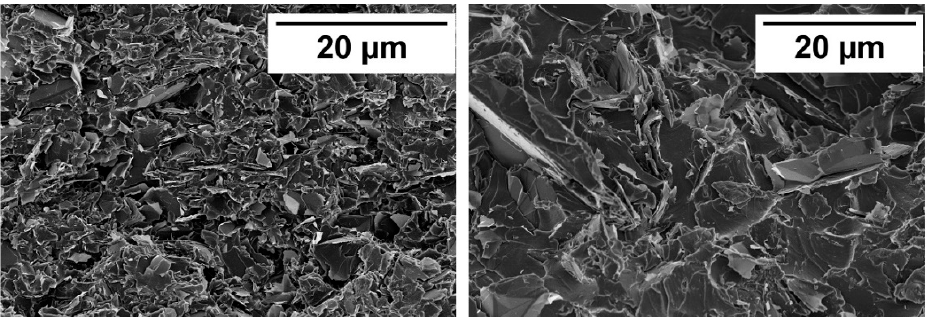
Figure 5. μ CT scans cut from LFA samples with small (left) and large (right) particles with a filler content of 15 vol.%.